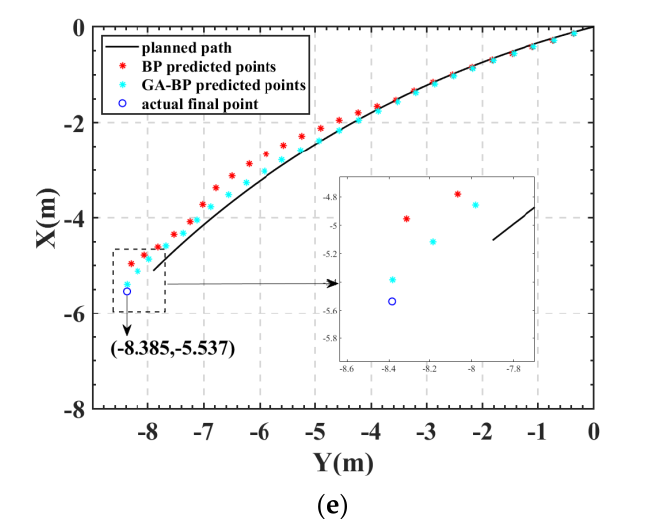
Figure 14. On-orbit planning path and predicted path from sol.27 – sol.36: ( a ) sol. 27; ( b ) sol. 28; ( c ) sol. 29; ( d ) sol. 34; ( e ) sol. 36.